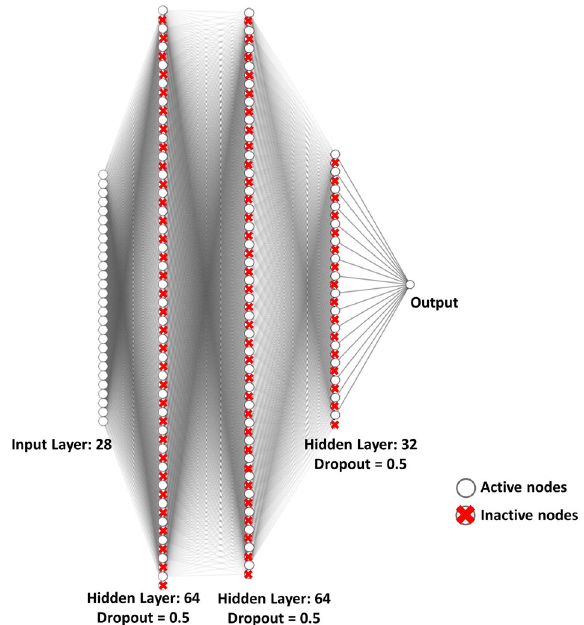
Fig. 7 Schematic representation of the fully connected deep neural network structure (with a dropout fraction of 0.5 for each hidden layer) used for